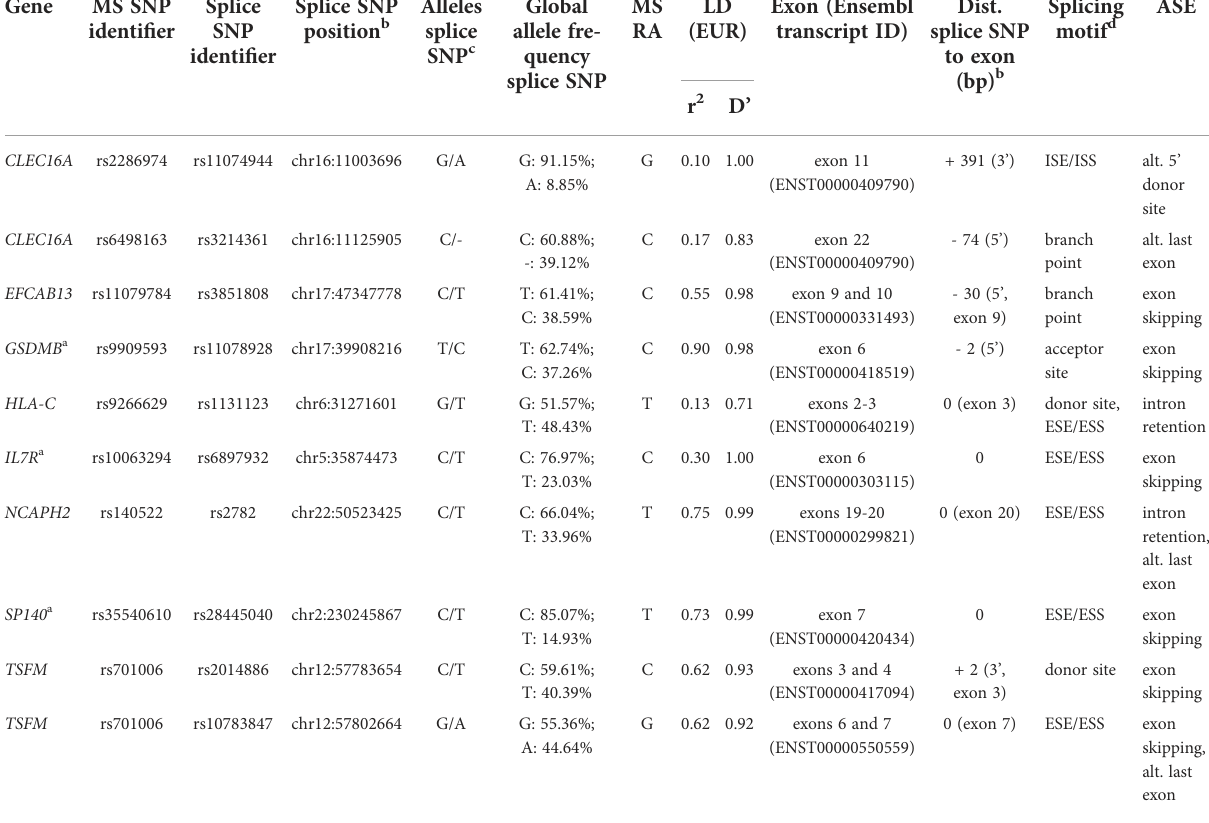
TABLE 1 Prioritized SNPs from MS – associated genetic regions that potentially alter the splicing pattern of eight